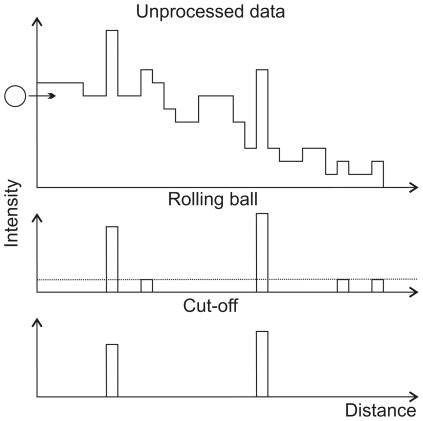
Schematic representation of the intensity distribution by an one-dimensional scan through the surface.A ‘rolling ball’ moves along (arrow) the underside of the intensity curve and thereby identifies the background, which is subsequently subtracted. Remaining peaks of low intensities are removed by an intensity cut-off (dashed line). In the algorithm, the ball moves along a three-dimensional landscape, identifying peaks with a two-dimensional bottom and the intensity as the third dimension.